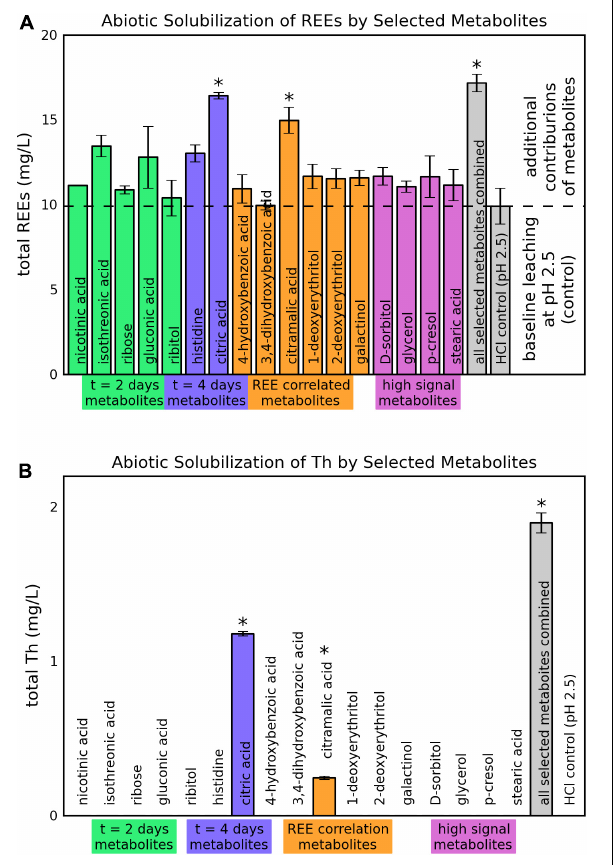
TABLE 1 | Metabolites of potential bioleaching importance that could be identified by chemical name.